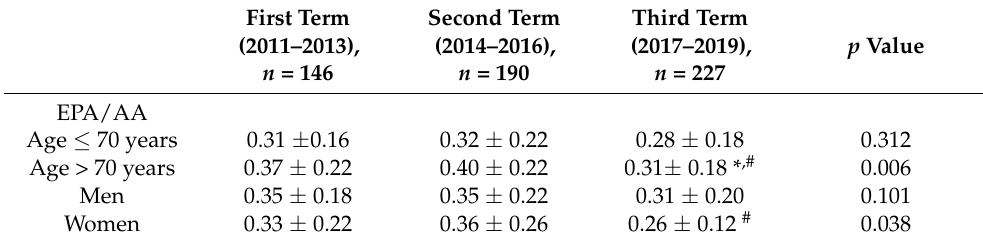
Continuous variables are presented as mean ± standard deviation. EPA, eicosapentaenoic acid; DHA, docosa- hexaenoic acid; DGLA, dihomo- γ -linolenic acid; AA, arachidonic acid. * p < 0.05 versus first term and # p < 0.05 versus second term. For multiple comparisons, the Bonferroni post-hoc test was applied.